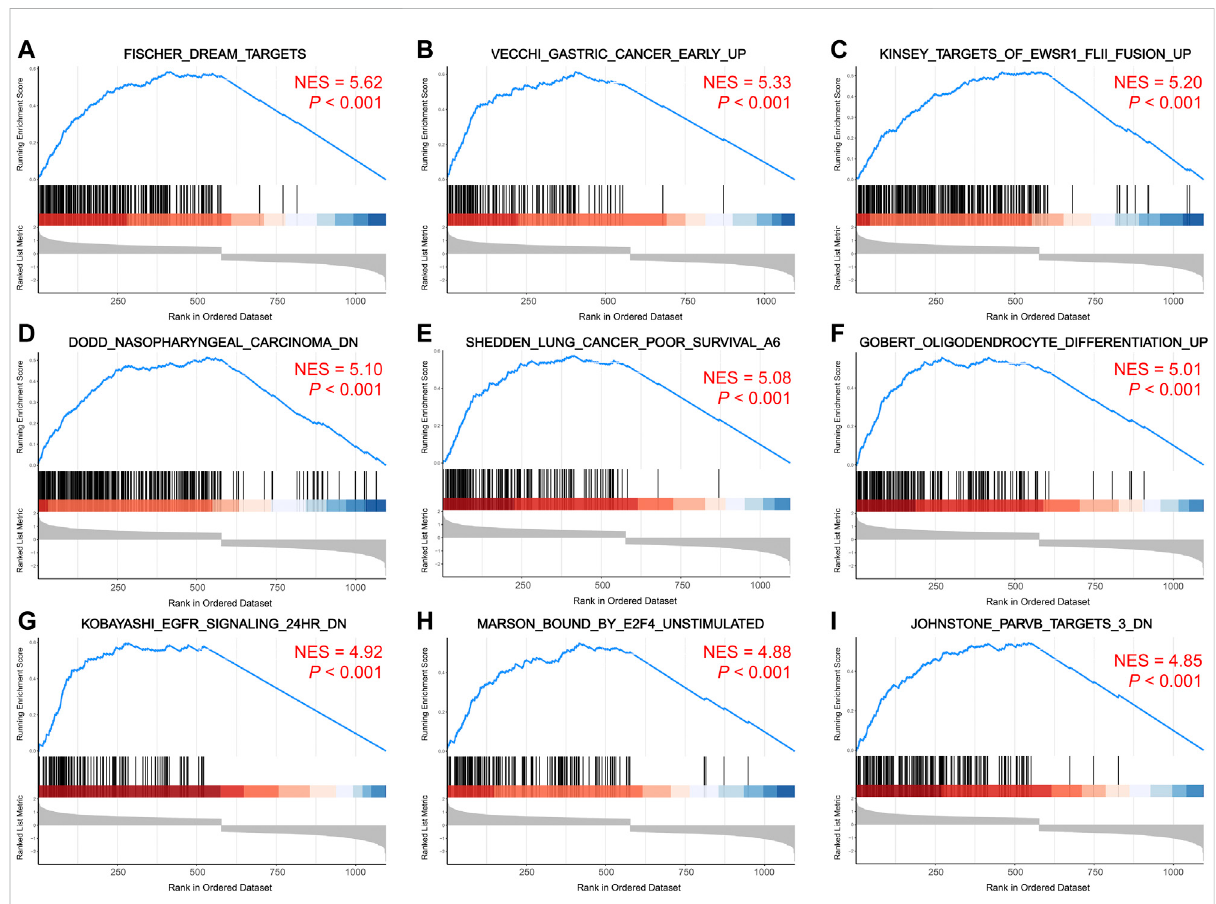
FIGURE 6 GSEA enrichment analysis of Hub genes. (A – I) . Top 9 pathways enriched for hub genes. The larger the NES value, the more genes are enriched in the pathway. GSEA, gene set enrichment analysis; NES, normalized enrichment